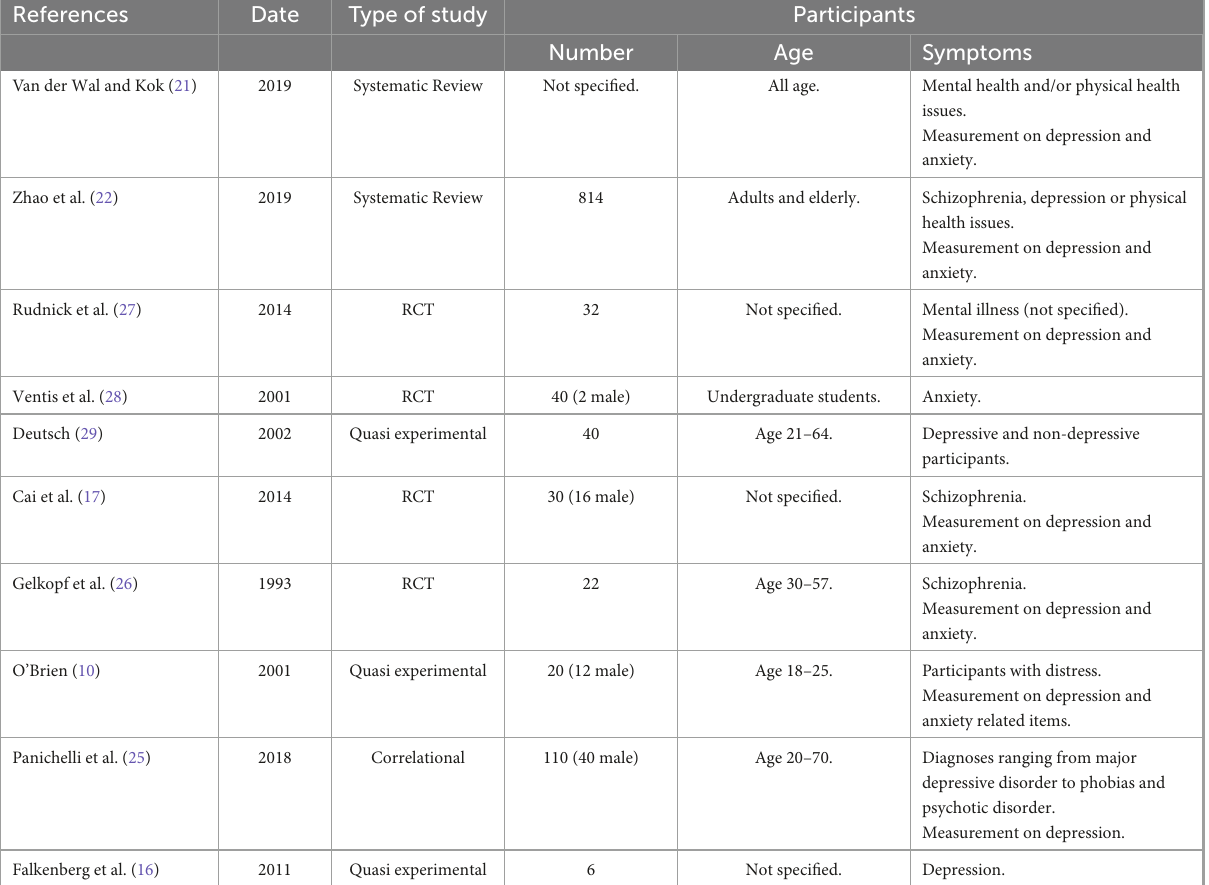
TABLE 1 Selected articles for qualitative synthesis.